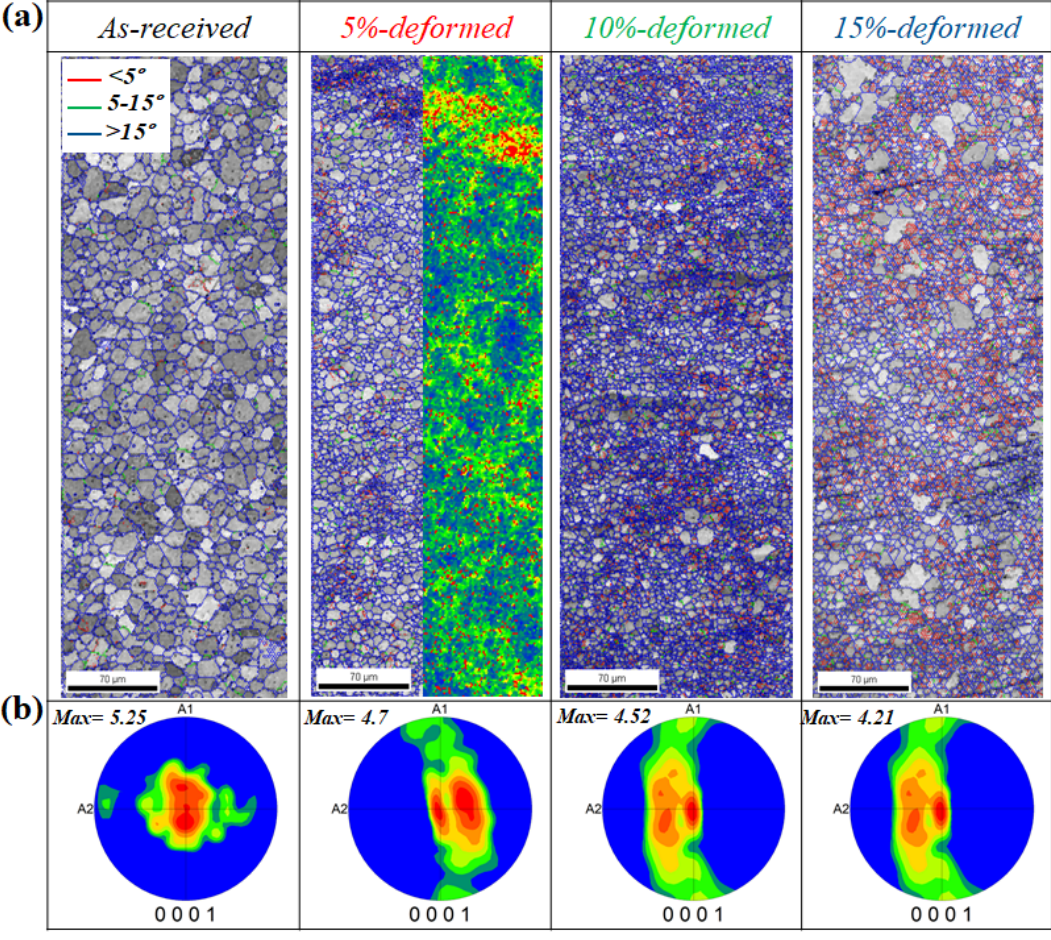
Figure 1. ( a ) Image quality (IQ) maps and ( b ) pole figures (PFs) of the as-received and stretched (5%, 10% and 15%) samples. Here, A1 and A2 are rolling direction (RD) and transverse direction (TD) of the samples, respectively. The KAM map of the 5% sample is inserted to show the